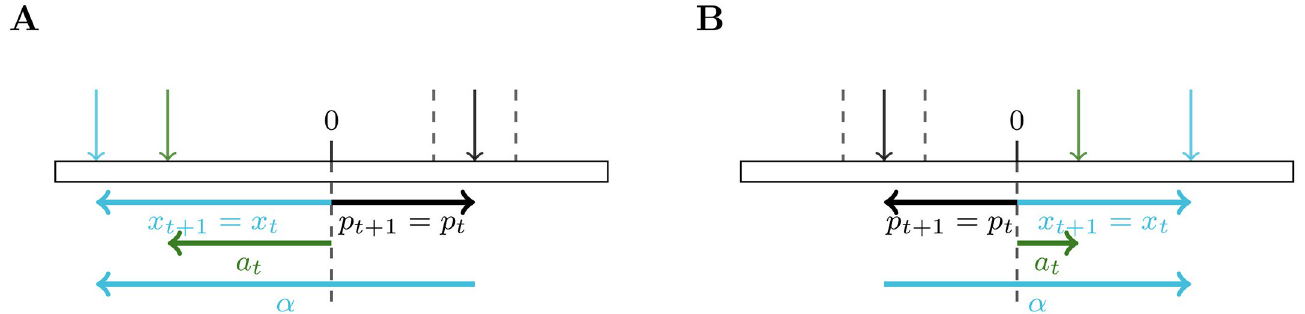
Fig 3. Sketch of a time-step interaction between an agent and two different tasks M (A and B) sampled in D for the first benchmark. Each task is defined by the bias α on the target’s position p t observed by the agent. x t is the observation made by the agent at time-step t and a t its action. For these examples, a t falls outside the target area (the zone delimited by the dashed lines), and thus the reward r action near the target, then it would have received a reward equal to 10 and the position of the target would have been re-sampled uniformly in [ − 5 − α , 5 − α ].